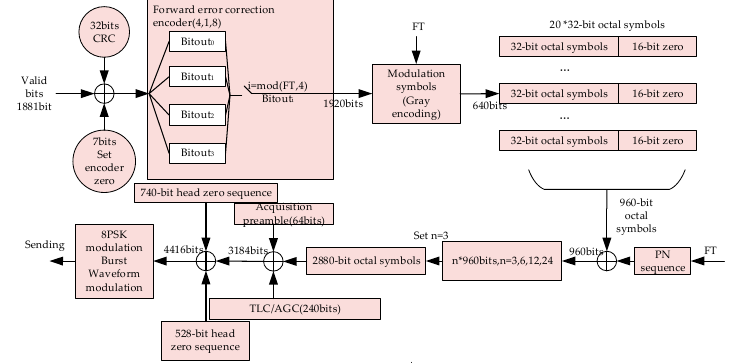
Figure 4. The transmission scheme of burst waveform BW2. FT: forward transmission.